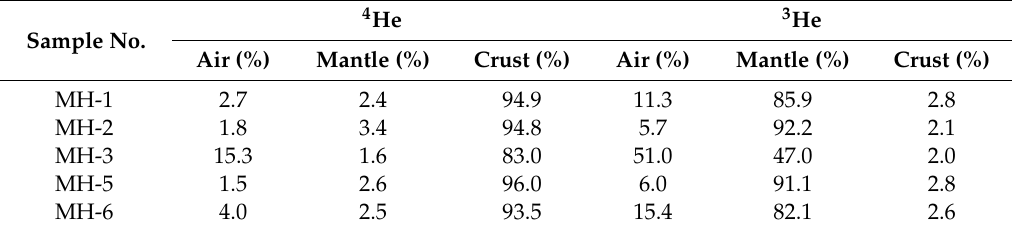
Table 3. Mixing ratios of three sources of 3 He and 4 He in Magumsan thermal waters. Sample No.